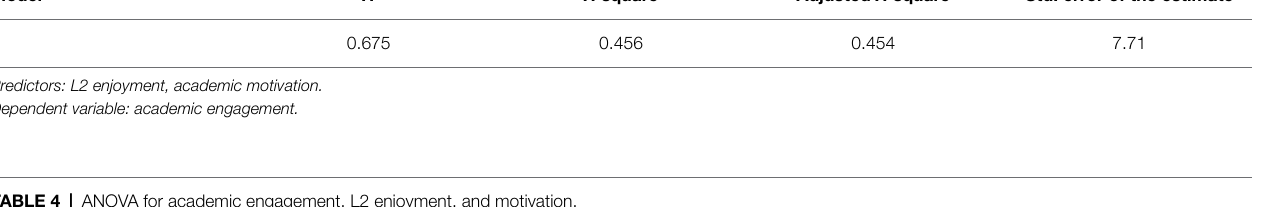
TABLE 3 | Model summary for academic motivation, L2 enjoyment, and academic engagement. Model